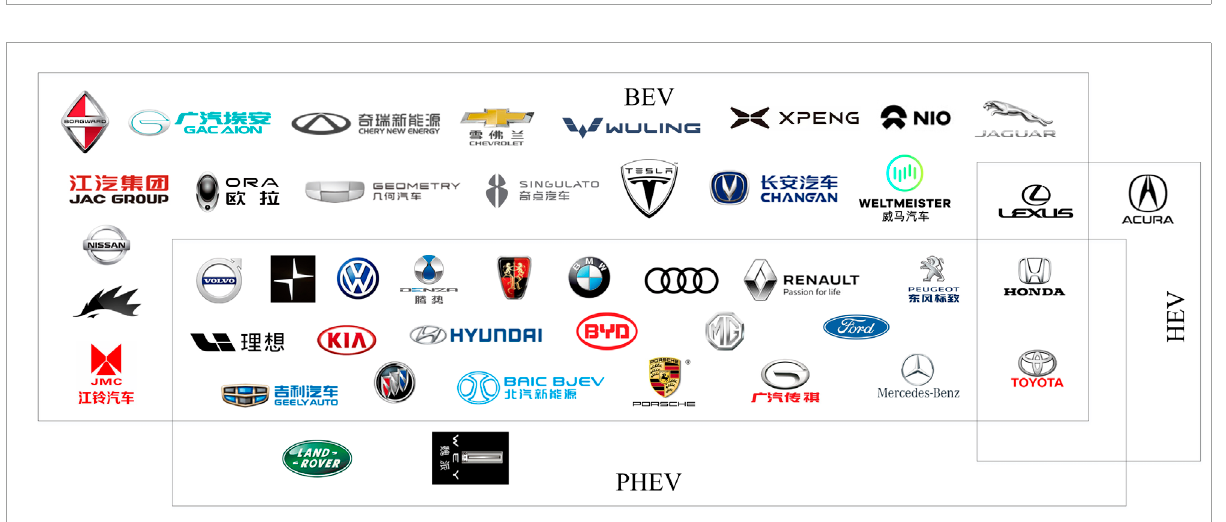
FIGURE 2 The distribution of new energy models released by influential car brands in the Chinese market in 2021. BEV: battery electric vehicle; PHEV: plug-in hybrid electric vehicle; HEV: hybrid electric